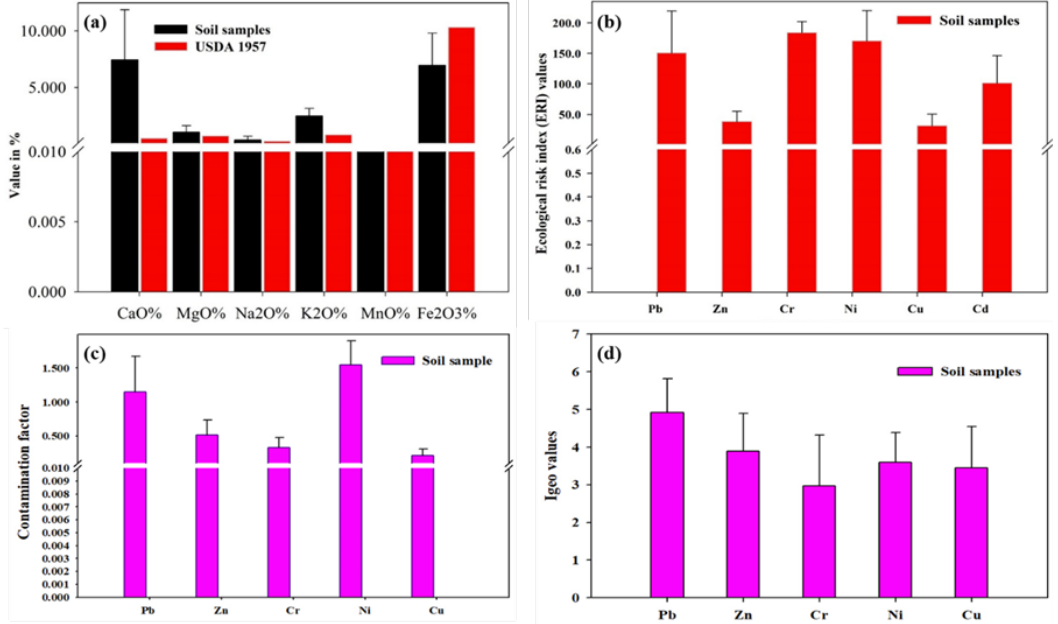
Figure 5. ( a ) A comparison of major oxides with the normal soil concentration of USDA [50] ; ( b ) potential ecological risk of trace elements in Makarwal soil; ( c ) contamination factor of Makarwal coal-mining-contaminated soil; ( d ) geoaccumulation index of Makarwal coal soil.